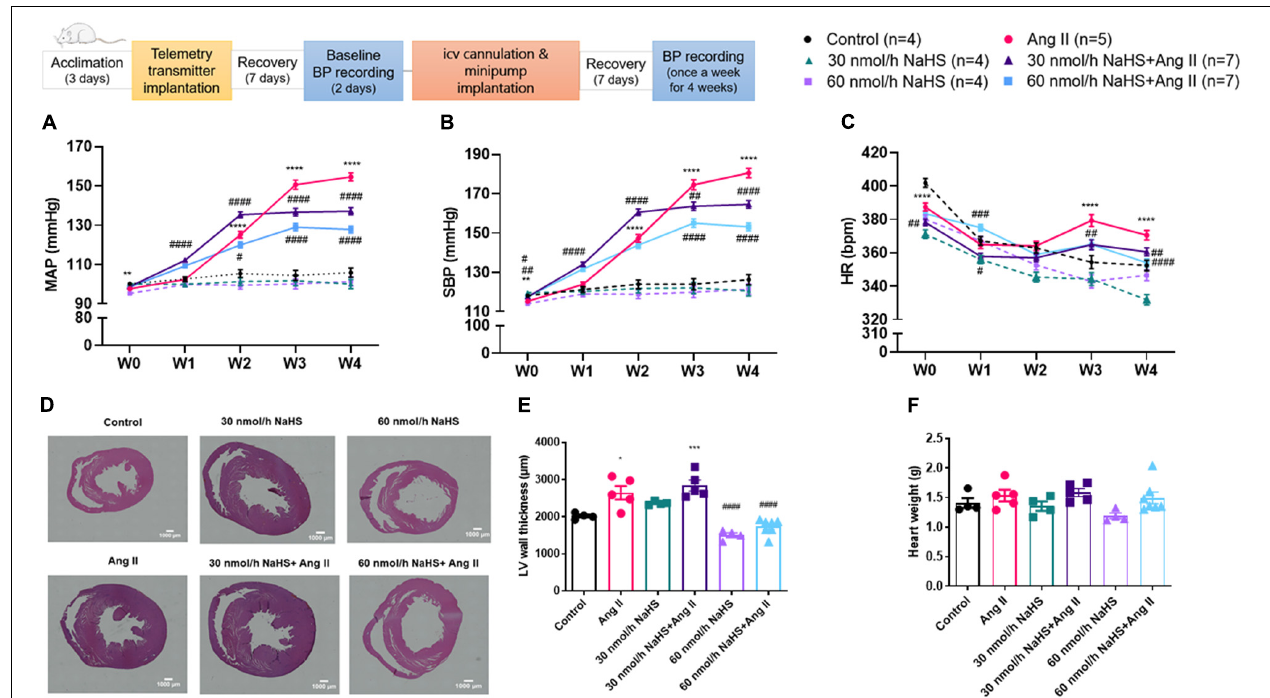
FIGURE 1 | Schematic representation of study design (ICV: intracerebroventricular; BP: blood pressure). Chronic ICV infusion of NaHS attenuated angiotensin (Ang) II–induced increase in (A) mean arterial pressure (MAP) and (B) systolic blood pressure (SBP) in Sprague–Dawley rats. (C) Ang II effect on heart rate (HR). Data was analyzed by Kruskal–Wallis H test followed by Tukey’s multiple comparisons test and presented as mean ± SEM. **** p < 0.0001, *** p < 0.001, ** p < 0.01, * p < 0.05 control vs. Ang II. #### p < 0.0001, ### p < 0.001, ## p < 0.01, # p < 0.05 Ang II vs. NaHS/Ang II-treated rats. In panels (D–E) , Ang II-induced left ventricular (LV) hypertrophy as measured by LV thickness was attenuated by 60 nmol/h but not 30 nmol/h NaHS ICV infusion. In panel (D) , representative images of H&E stain in ventricular sections of experimental groups (magnification: × 4, scale bar = 1000 µ m). In panel (E) , LV wall thickness ( µ m) and (F) heart weight (g). Data were analyzed by one-way ANOVA followed by Tukey’s multiple comparisons test and presented as mean ± SEM. *** p < 0.001, * p < 0.05 Control vs. all other groups. #### p < 0.0001 Ang II vs. all other